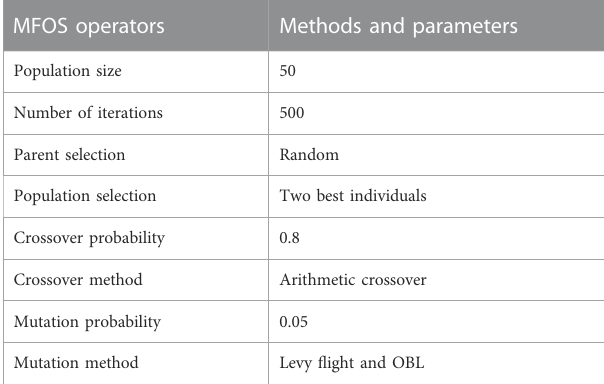
TABLE 1 MFOS ’ s operators and parameter